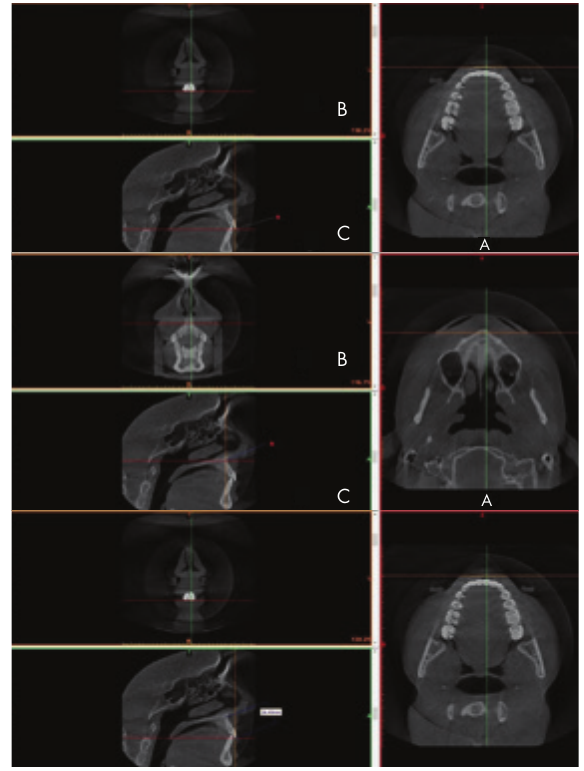
Figure 2. Axial Multiplanar Reconstruction. Use of axial (A) and coronal (B) views to locate the incisal edge (A) and apex (B) of the central incisor in sagittal (C) view. This allows a measurement of tooth length to be